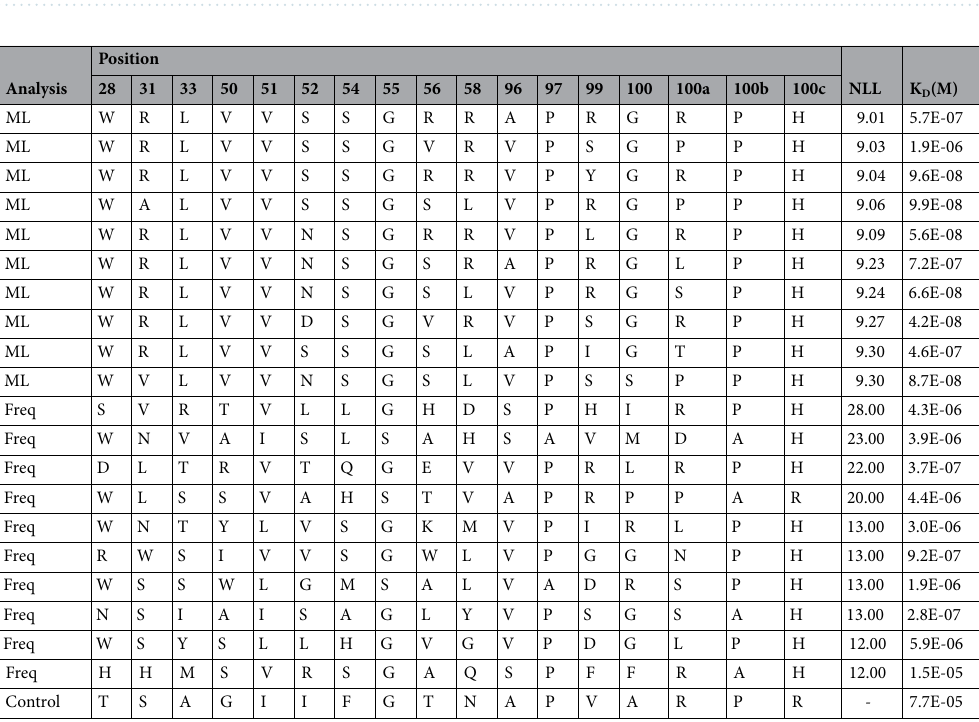
Figure 8. NLL distribution of training and generated sequences. NLL was calculated by applying the trained LSTM model. Enlarged view from 9.00 to 11.0 for x –axis and 0 to 0.05 for y-axis (right).